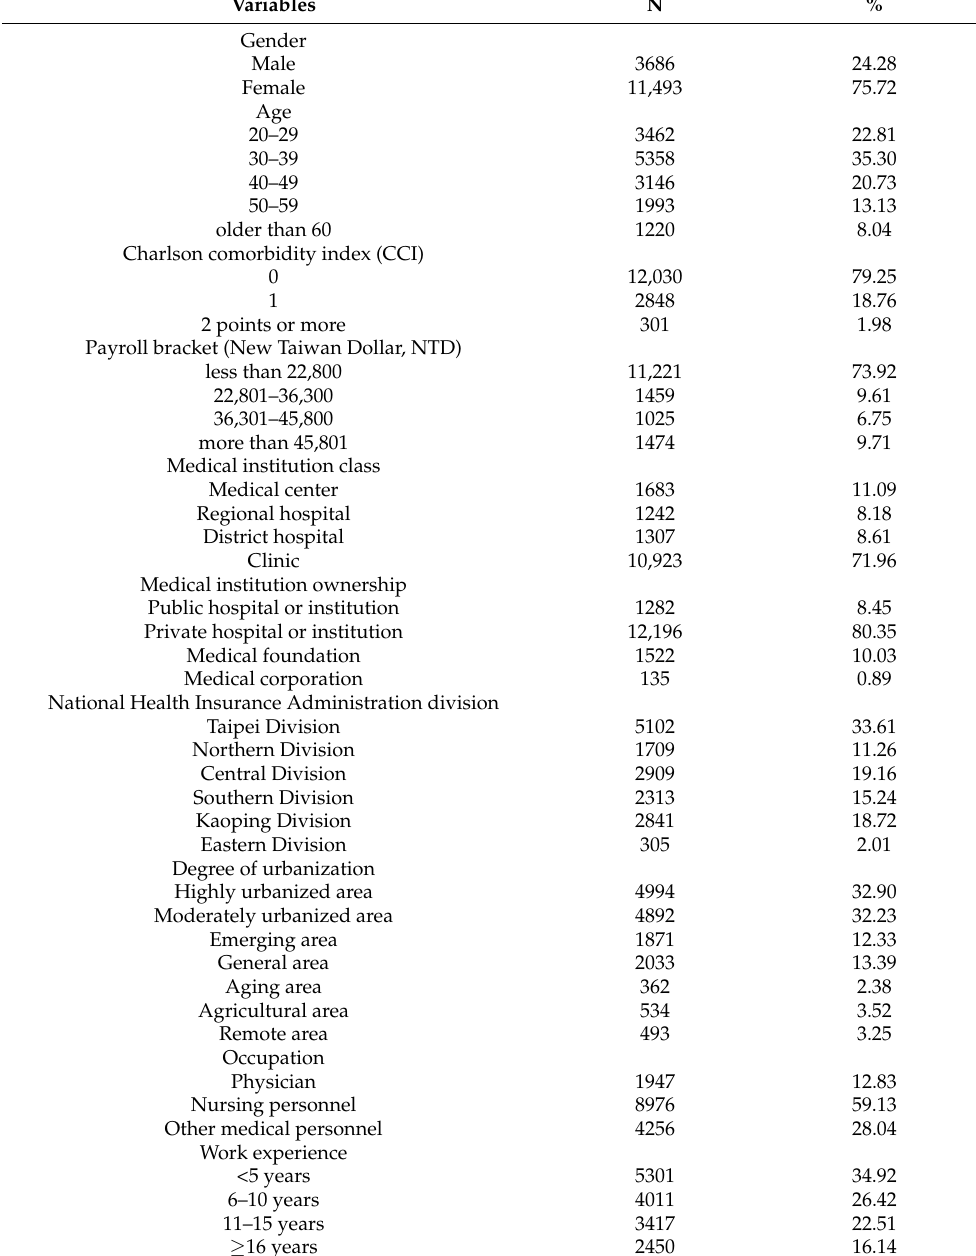
Table 2. Characteristics of the samples studied (N =